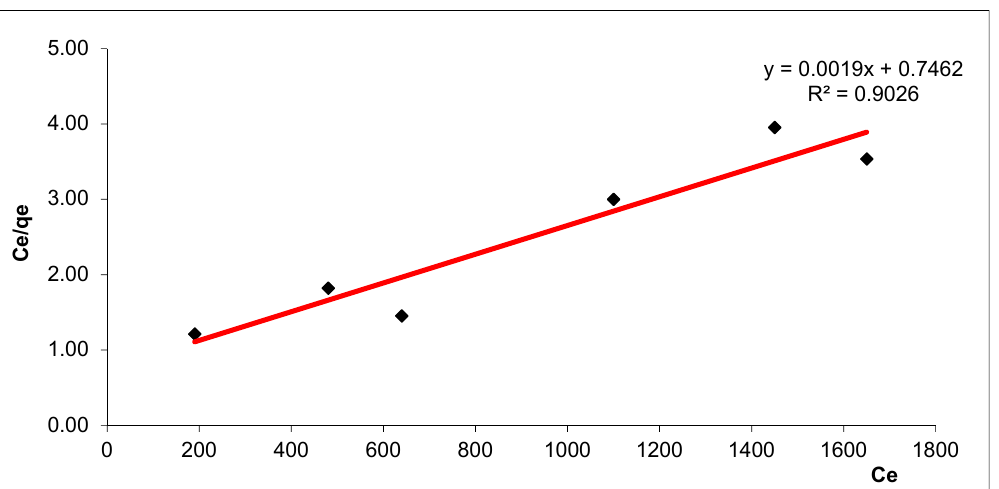
Figure 6. Langmuir adsorption isotherm. Table 5. Freundlich and Langmuir isotherm constants for the adsorption of COD in GAC.